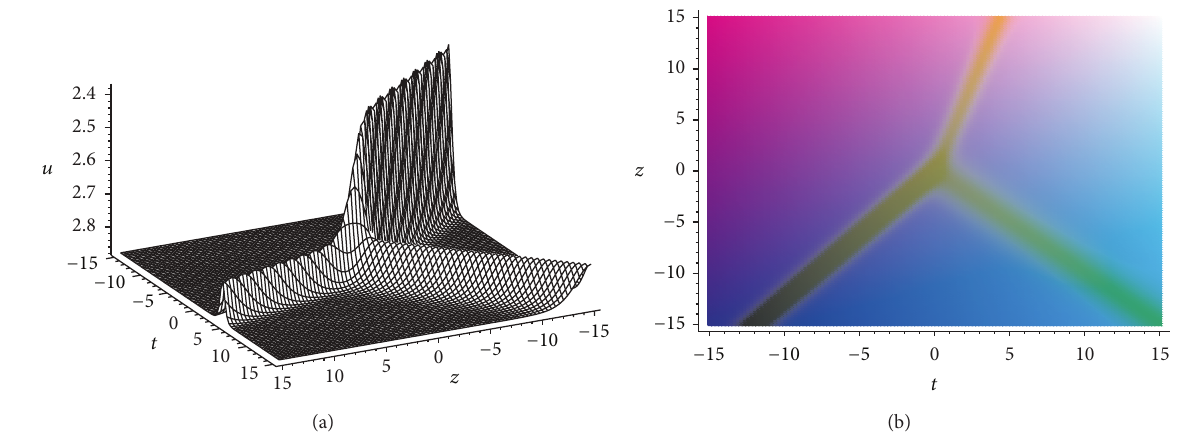
Figure 1: Plot of the interaction solution between one soliton and one resonant soliton solution for field 𝑢 with the parameters 𝑘 = 1 / 2, 𝑏 = 1, = 1 / 4, 𝑙 = 1 / 4, 𝑏 = 1 / 2, and 𝜔 = 1 / 2. (a) Three-dimensional image at 𝑥 = 𝑦 = 0. (b) The density plot of the corresponding 𝑘 0 0 0 0